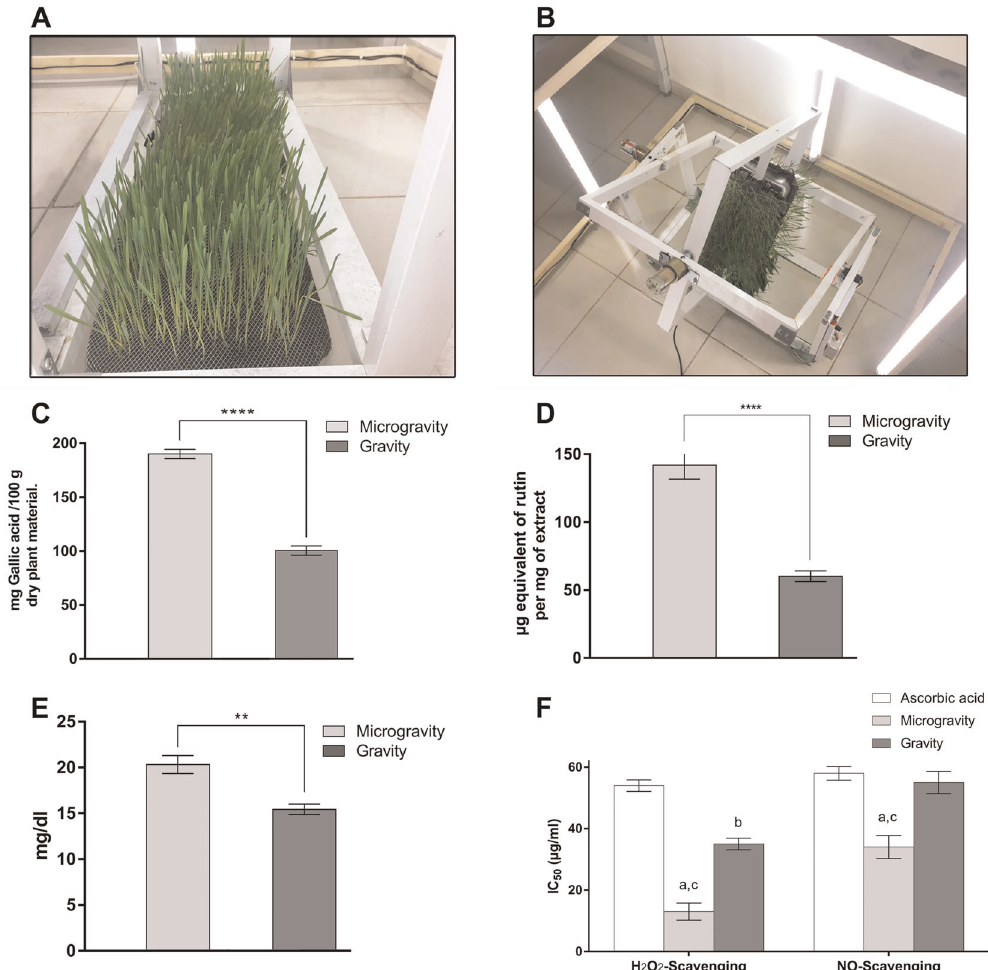
Fig. 1 Triticum aestivum growth under gravity and microgravity conditions and the effect of simulated microgravity on the total phenolic content, total fl avonoid content, vitamin C content, and total antioxidant activities in wheatgrass extract. a shows T. aestivum growth under gravity conditions. b shows T. aestivum growth under microgravity conditions simulated by a three-dimensional clinostat. c shows the total phenolic content of ethanolic extracts of T. aestivum under gravity and microgravity conditions. d shows the total fl avonoid content of ethanolic extracts of T. aestivum under gravity and microgravity conditions. e shows the vitamin C content of ethanolic extracts of T. aestivum under gravity and microgravity conditions. f shows the hydrogen peroxide- and nitric oxide radical-scavenging activities of ethanolic extracts of T. aestivum under gravity and microgravity conditions. The values are expressed as the mean ± SEM of seven rats in each group. Data in c – e were analyzed by using two-way ANOVA, followed by Tukey ’ s multiple comparison test with the level of signi fi cance set at P < 0.05. *, **, ***, **** = P < 0.05, P < 0.01, P < 0.001, and P < 0.0001, respectively. Data in f were analyzed by using two-way ANOVA, followed by Tukey ’ s multiple comparison test with the level of signi fi cance set at P < 0.05. a refers to microgravity versus a reference compound ascorbic acid; b refers to gravity versus a reference compound ascorbic acid; and c refers to microgravity versus a and WGM conditions. The TPC is expressed as mmol equivalents of gallic acid/100 g fresh weight. In the ethanolic extract of WGM, the TPC (190.0 ± 2.11 mmol) was found to be signi fi cantly higher ( P < 0.0001; TPC of extracts by two-way analysis of variance (ANOVA), followed by Tukey ’ s multiple comparison test) than that of the ethanolic extract of wheatgrass grown under gravity (100.4 ± 2.15 mmol), as shown in Fig. 1c. Our results present the total fl avonoid content (TFC) of ethanolic extracts of WGG and WGM conditions. The TFC is expressed as mmol equivalents of rutin/mg fresh weight. The TFC of the ethanolic extract of WGM was signi fi cantly higher (208.1 ± 6.57 mmol) ( P < 0.0001; TFC of extracts by two-way ANOVA followed by Tukey ’ s multiple comparison test) than the TFC of the ethanolic extract of WGG (30.68 ± 4.01 mmol), as shown in Fig. 1d. Vitamin C, also known as ascorbic acid, is an antioxidant compound and a component of an enzyme required for protein